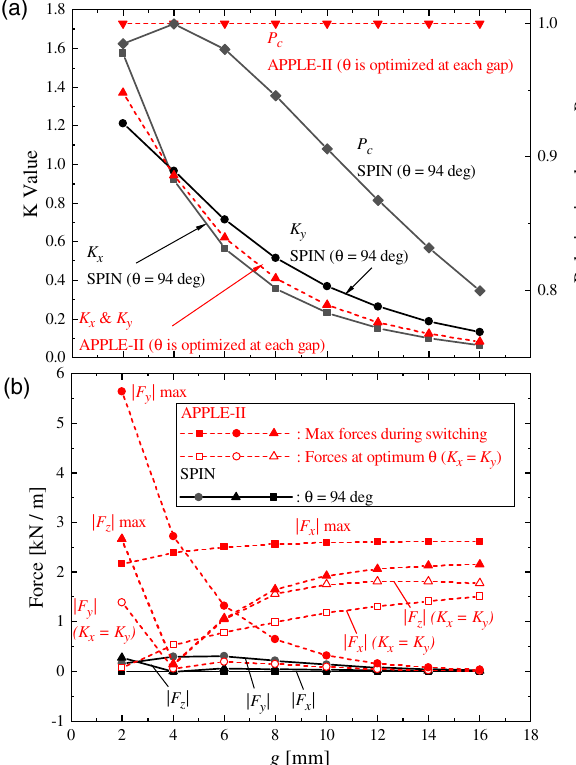
FIG. 7. Comparison between the APPLE and SPIN undula- tors in terms of (a) the K values and the degree of circular polarization P , and (b) the magnetic force, calculated as a c function of the gap value.